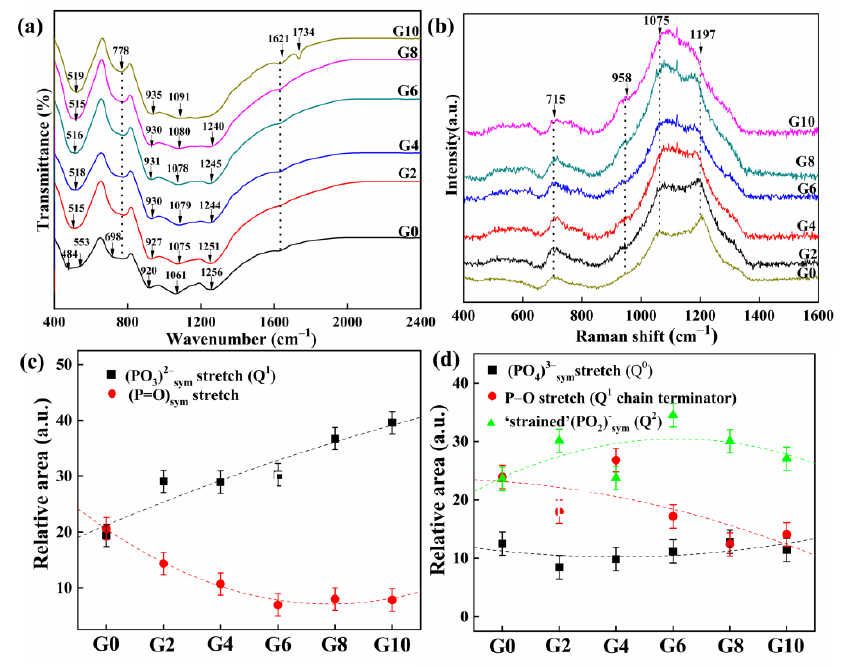
Figure 2. ( a ) IR and ( b ) Raman spectra of yttrium phosphate glasses. ( c , d ) Relative area dependence of bands in the Raman spectra of glass samples. The lines are drawn as guides for the